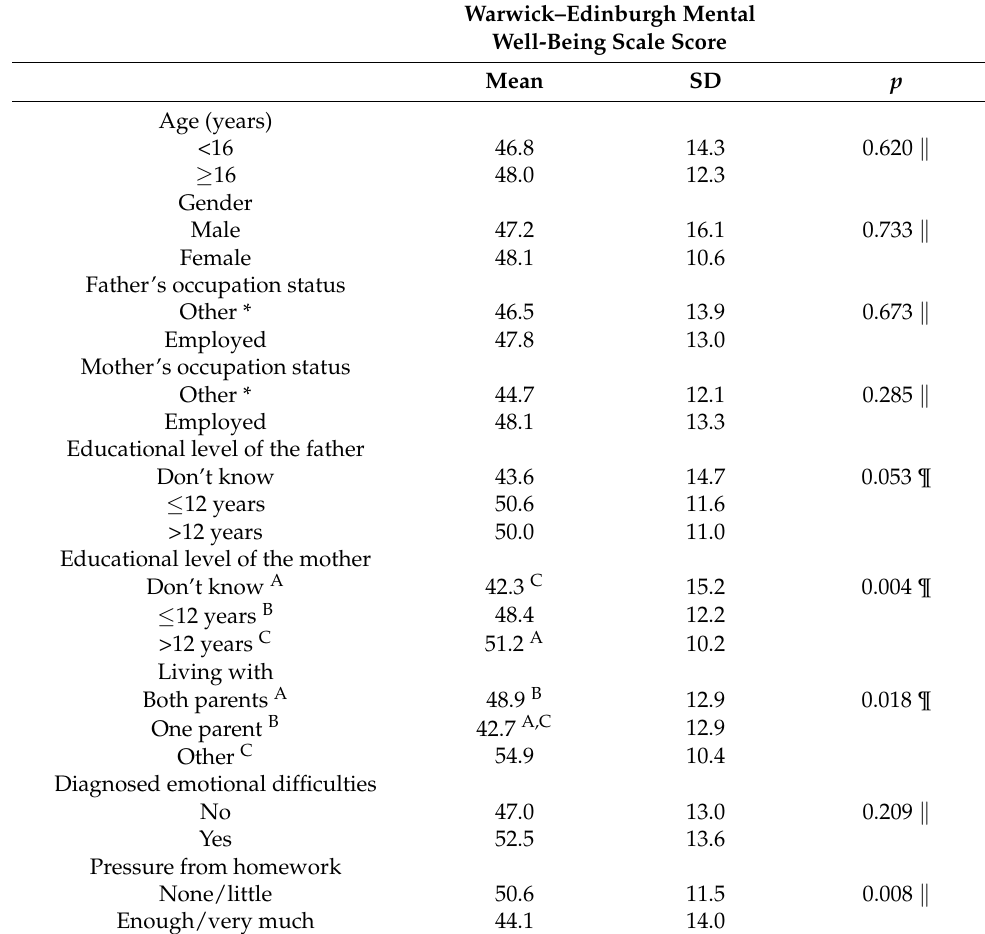
Table 2. Associations of sociodemographic variables with the level of mental wellbeing.